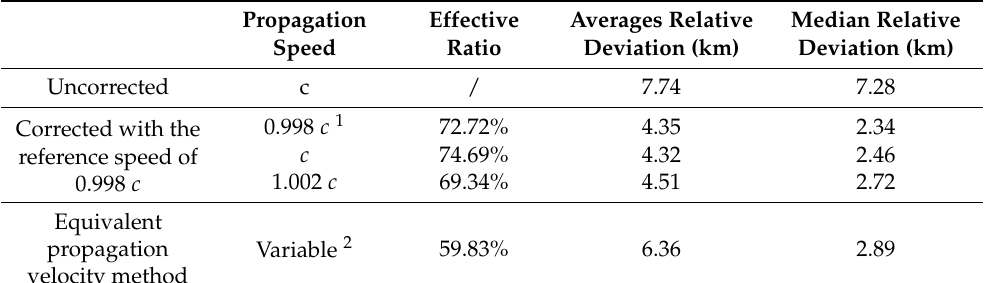
Figure 7. Distribution of relative position deviation before propagation correction and after applying propagation correction with a reference speed of 0.998 𝑐 and different propagation speeds. Table 1. Relative location accuracy metrics for uncorrected and propagation corrected with a reference speed of 0.998 𝑐 .